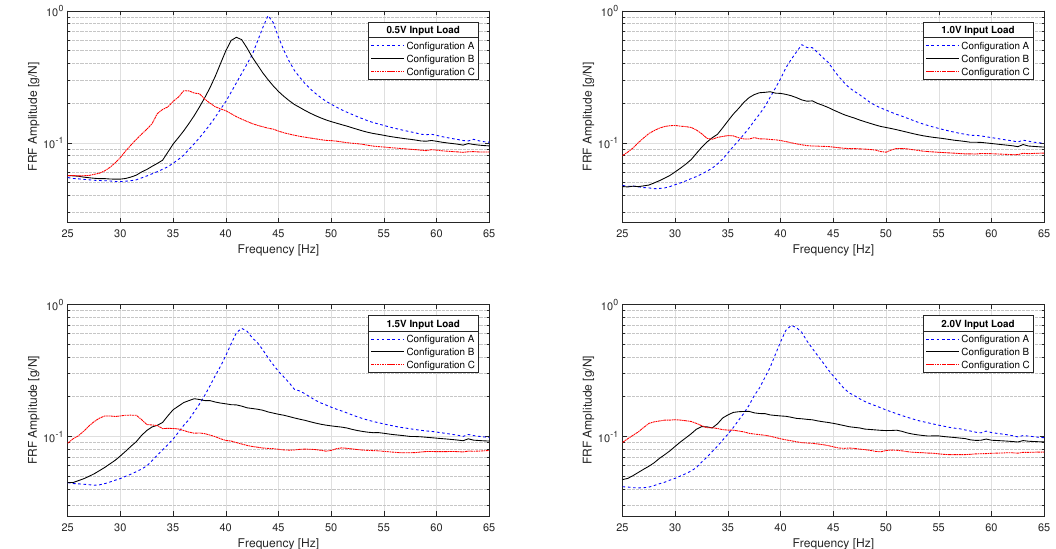
Figure 5. Comparison of configuration A, B and C for the sweep up excitation with an amplitude level of 15 N (or 0.5 V) ( top left ), 30 N (or 1V) ( top right ), 45 N (or 1.5 V) ( bottom left ) and 60 N (or 2 V) ( bottom right ).